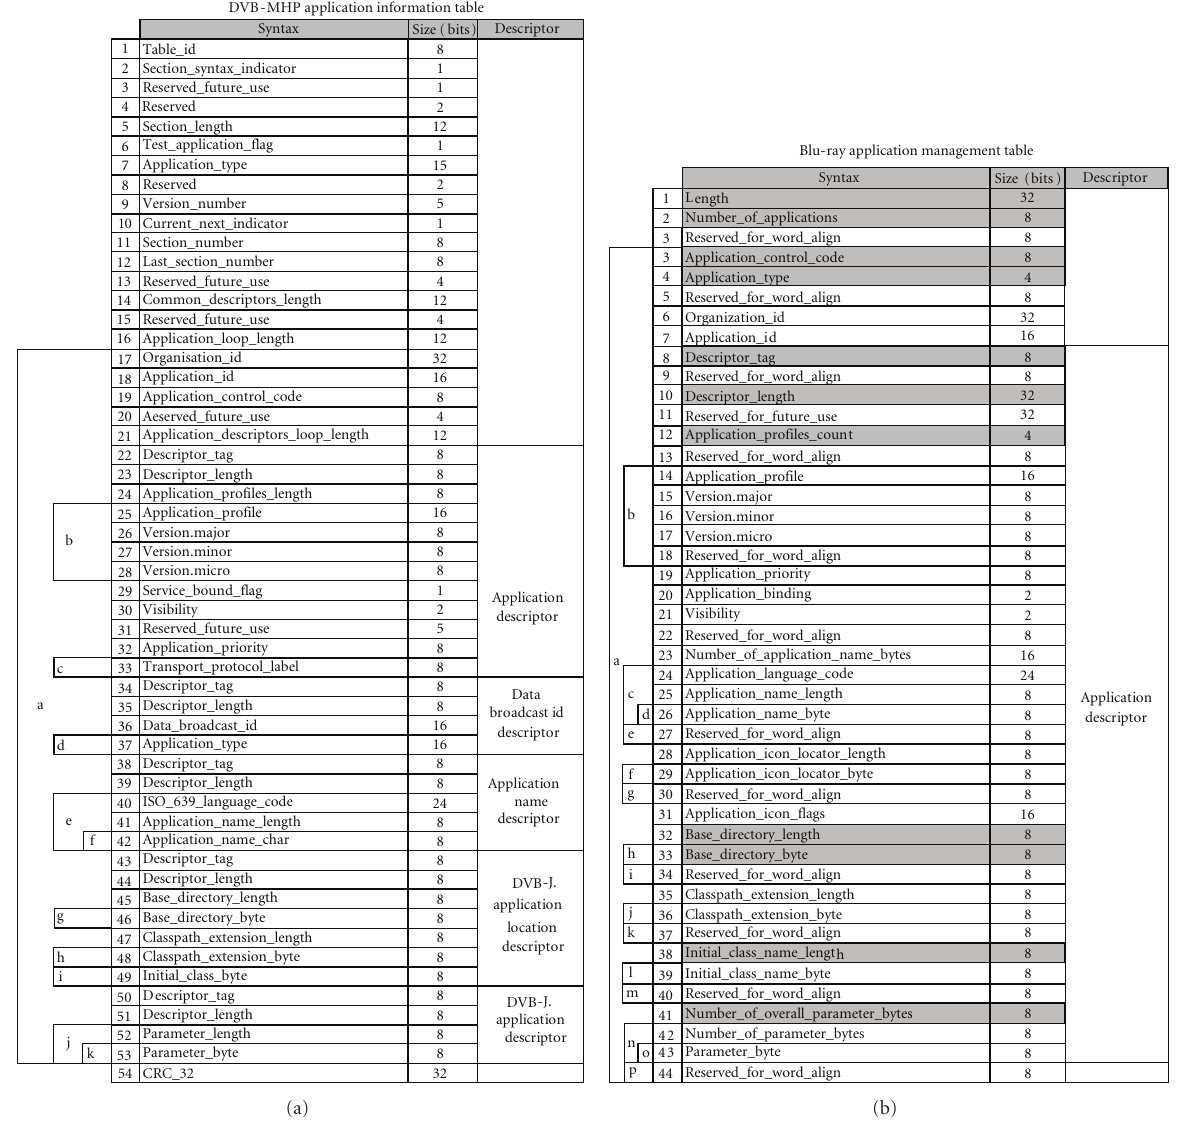
Figure 14: Application information table (AIT) (a) and application management table (AMT) (b).